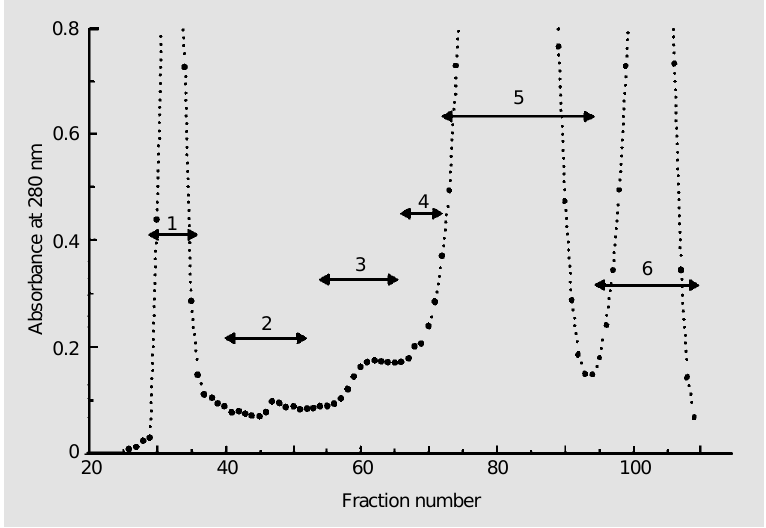
Figure 1. Gel filtration of 1 g of the venom of Bunodosoma cangicum on Sephadex G-50. The freeze-dried sample was applied to a Sephadex G-50 column (1.9 x 131 cm), equili- brated in 0.10 M ammonium acetate, pH 7.0. Fractions of 5 ml/15 min were collected and absorbance was measured at 280 nm. The fractions were pooled as shown in the figure (Bcg-1 to